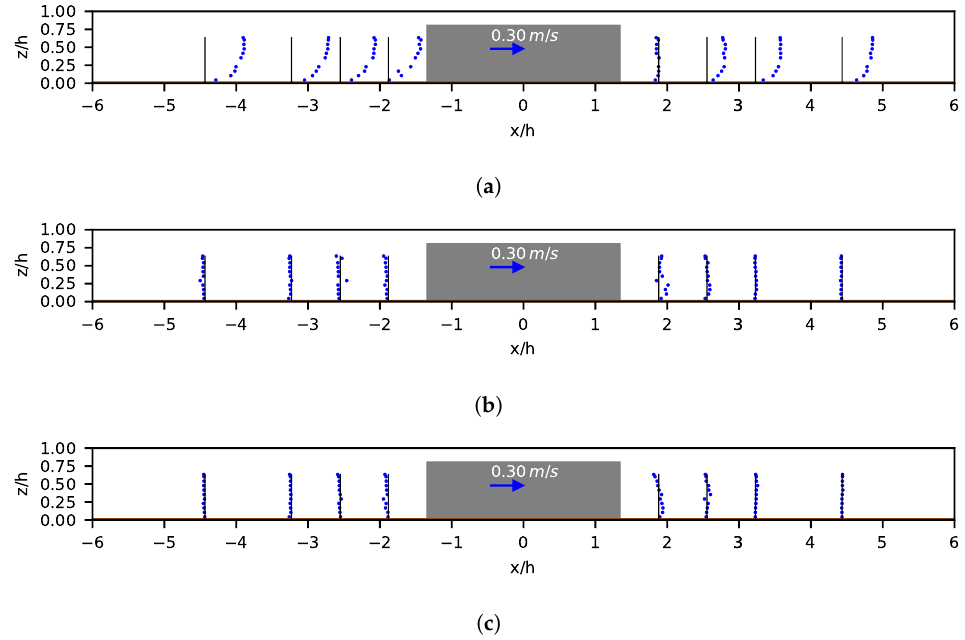
Figure 7. Vertical profiles of the velocity components along the pier’s mid-plane for Exp . 1 U Fbed . ( a ) Stream-wise component of velocity ( u ). ( b ) Cross-wise component of velocity ( v ). ( c ) Vertical component of velocity ( w ).